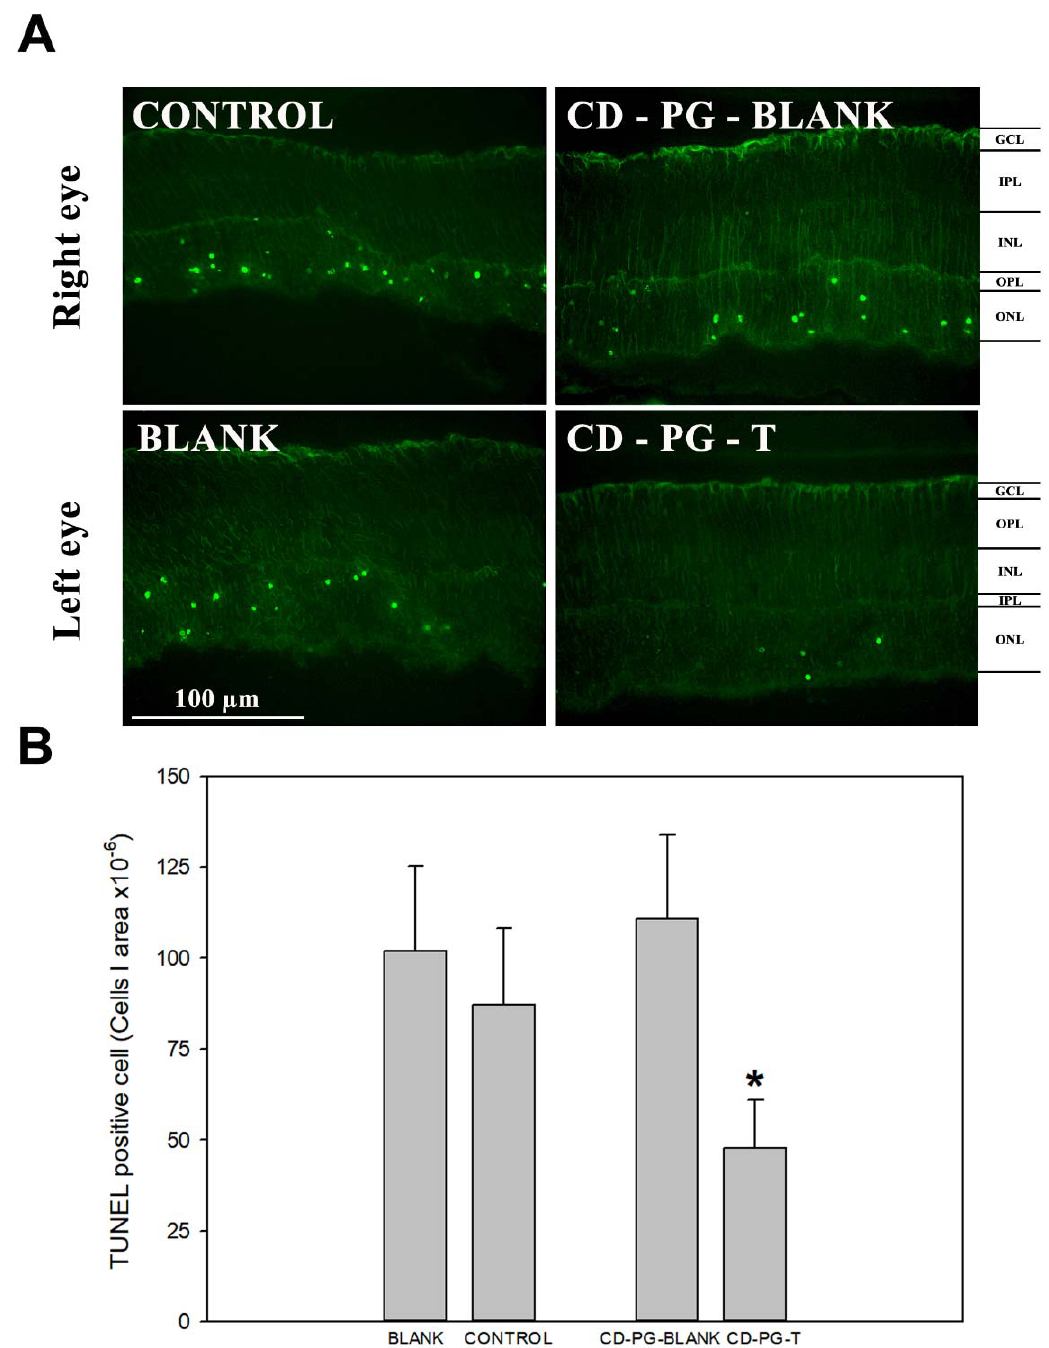
Figure 2. TUNEL immunofluorescence. ( A ) An example of TUNEL staining for each experimental group. ( B ) Results of TUNEL quantification. *: Statistically significant difference ( p -value < 0.05) of CD-PG-TE vs. control, blank, and CD-PG-blank.